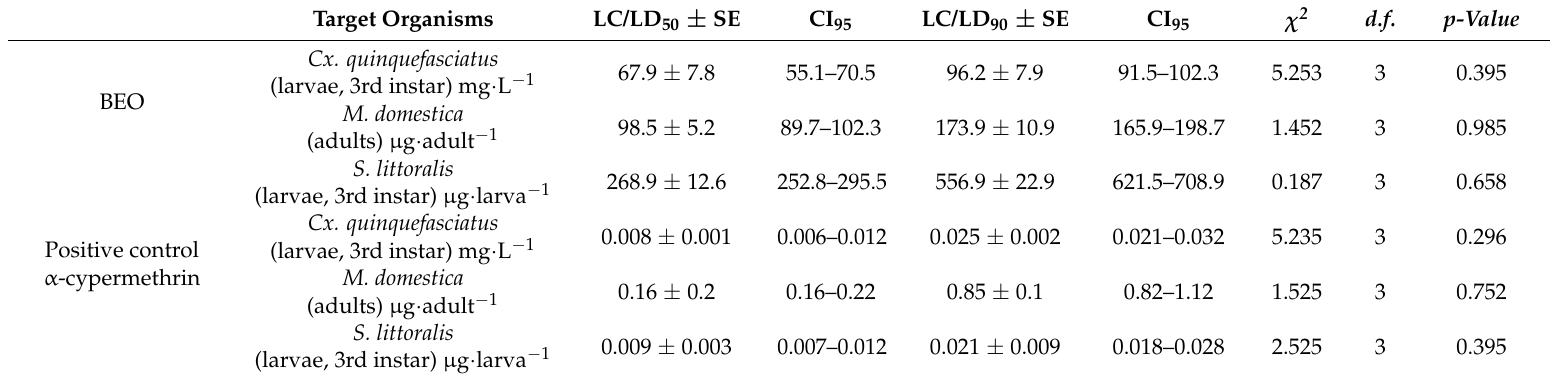
Table 2. Lethal concentrations (LC) and lethal doses (LD) of Peumus boldus leaf essential oil and positive control against target